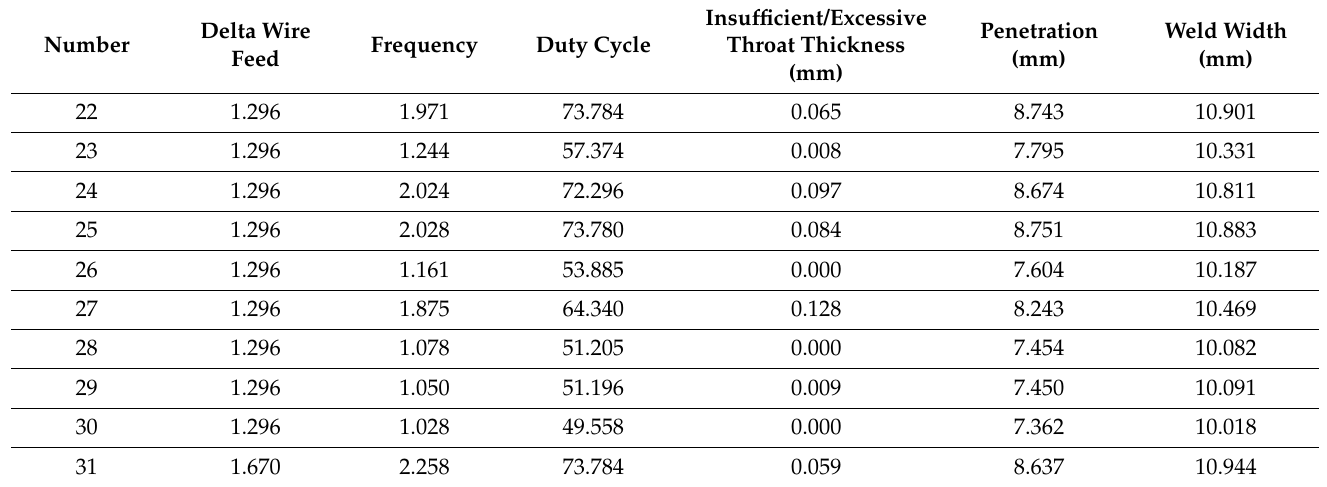
Figure 13. Optimal parameters for achieving as much penetration as possible.